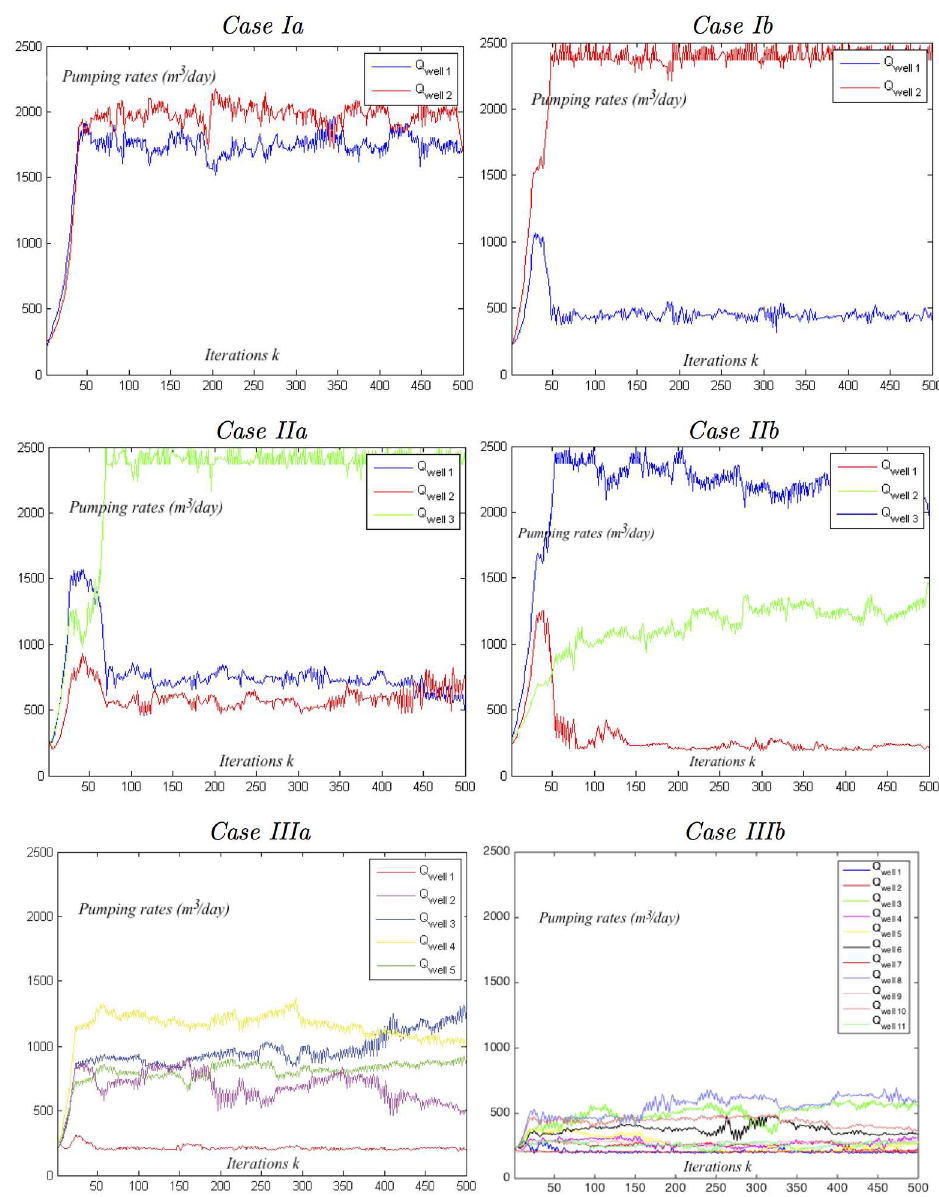
ð m 3 = day Þ for all simulation j